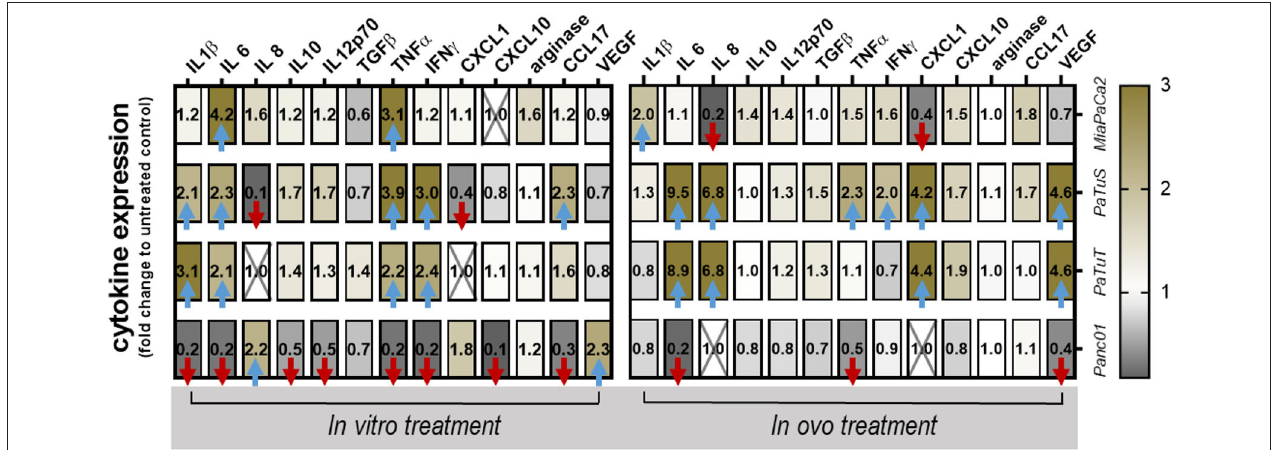
FIGURE 4 | Plasma treatment modulated the chemokine and cytokine profile of pancreatic cancer cells. Quantification of pro and anti-inflammatory cytokines and chemokines 4h after exposure of the cells to plasma in vitro , or after rinsing untreated or plasma-treated tumors on the CAM. The concentrations of the soluble factors were normalized to the respective untreated control, and the fold change of their secretion was blotted in the heat-map, showing the numerical value of the fold change. Decreased cytokine secretion is shown in gray, no change in white, and increased secretion in olive colors. Data are compiled from over 1,000 single data points, and show means of three independent experiments ( in vitro ) and 4–5 eggs per group ( in ovo ) over untreated control = 1. Crossed-out data (X) was at the upper limit of detection of the assay except for CXCL10 in MiaPaCa2, which was at the lower limit of detection. Blue arrows indicate upregulation of > 2-fold; red arrows indicate downregulation >